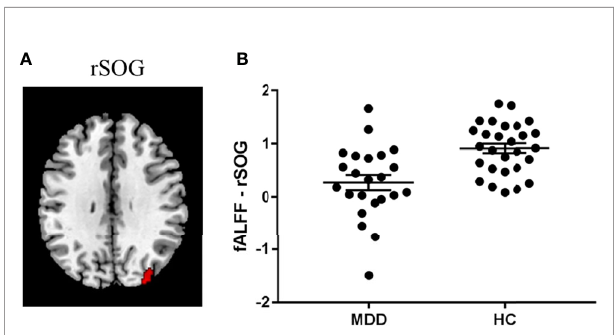
FIGURE 2 | Diagnosis effect on fALFF. (A) Region showing signi fi cant group difference in fALFF between the patients with major depressive disorder (MDD) and the healthy controls (HC). (B) The fALFF value in this region within each group. Abbreviation: rSOG, right superior occipital gyrus.